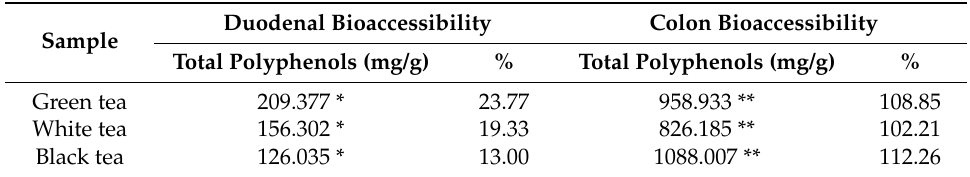
Table 3. Intestinal bioaccessibility of tea polyphenols evaluated by HPLC-DAD method after the simulated in vitro digestion.